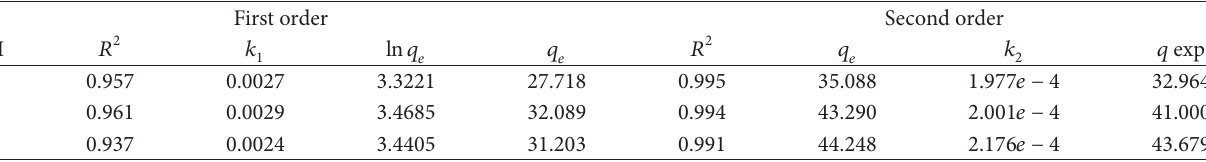
values for the pseudo-�rst- and -second-order reaction 𝑞𝑞 𝑒𝑒